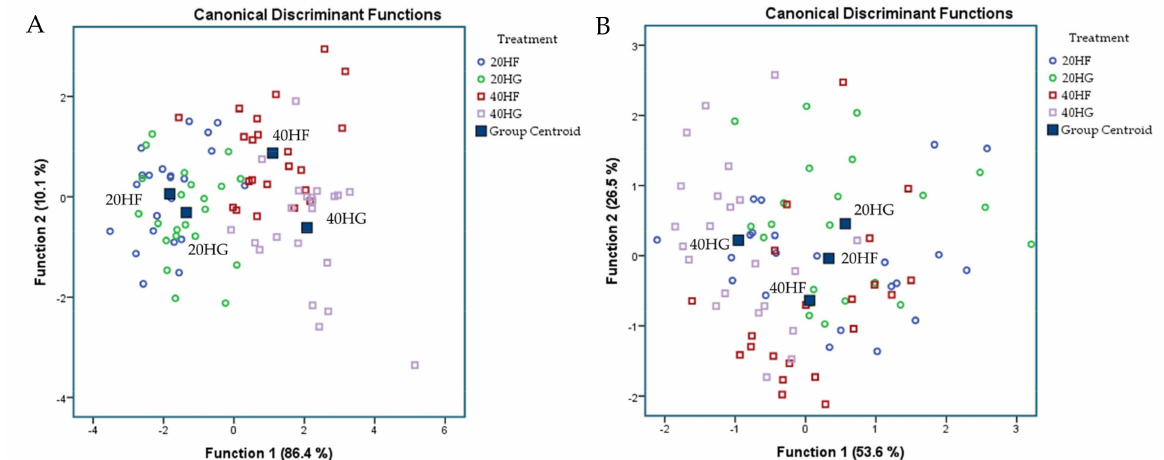
Figure 5. Discriminant plots separating ( A ) the four dietary treatments (20 HF; blue, 20 HG; green, 40 HF; red, and 40 HG; pink) according to pooled data of two sampling time (21st and 42nd experimental day) on the blood plasma oxidative status and ( B ) the four dietary treatments (20 HF; blue, 20 HG; green, 40 HF; red, and 40 HG; pink) according to pooled data of two sampling time (21st and 42nd experimental day) on the milk oxidative status. 20 HF: 20 g Schizochytrium spp. and high forage diet (60:40); 20 HG: 20 g Schizochytrium spp. and high grain diet (40:60); 40 HF: 40 g. Schizochytrium spp. and high forage diet (60:40); 40 HG: 40 g Schizochytrium spp. and high grain diet